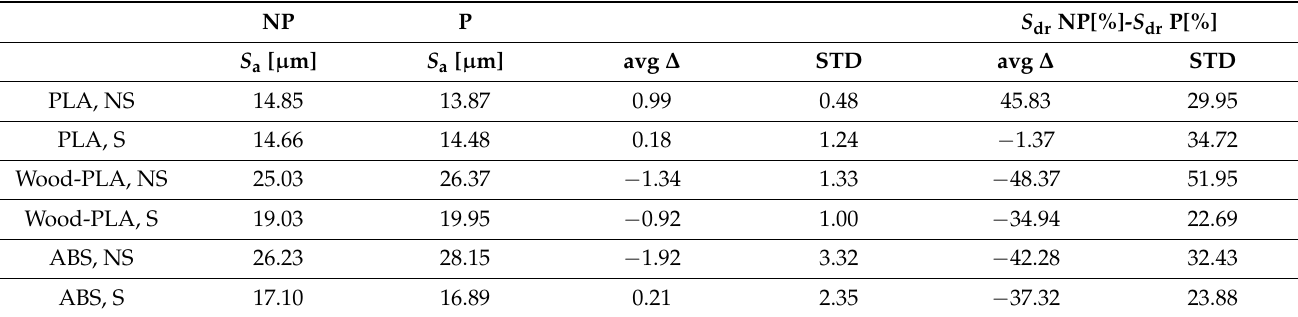
Table 1. Average surface roughness parameters S a and S dr measured on samples from acrylonitrile-butadiene-styrene (ABS), polylactic acid (PLA) and Wood-PLA, non-sanded (NS) and sanded (S) surface, non-treated (NP) and treated with plasma